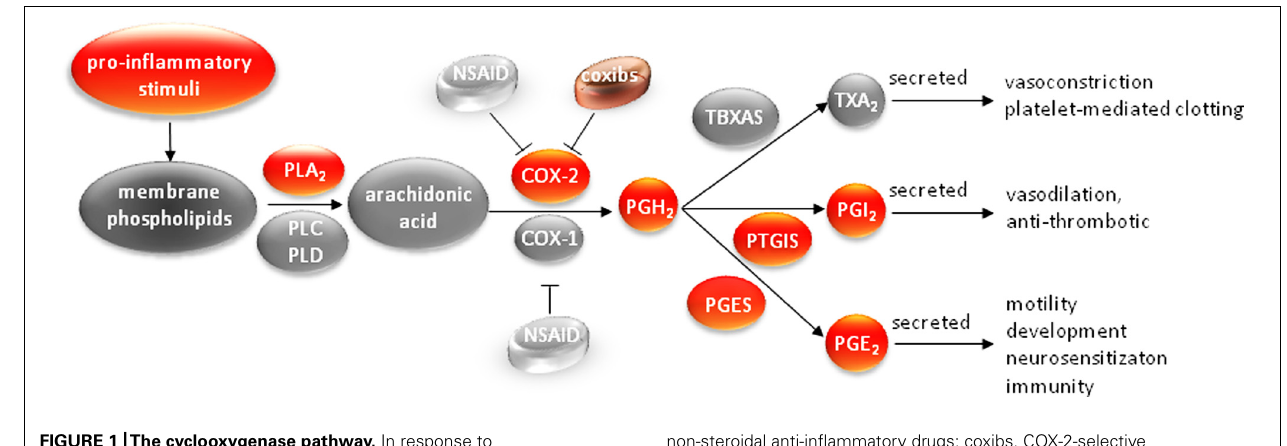
FIGURE 1 |The cyclooxygenase pathway. In response to pro-inflammatory stimuli COX-2 is expressed in the cytoplasm of many cell types where it catalyzes the conversion of arachidonic acid to prostaglandins and thromboxanes. PL, phospholipase; NSAID,